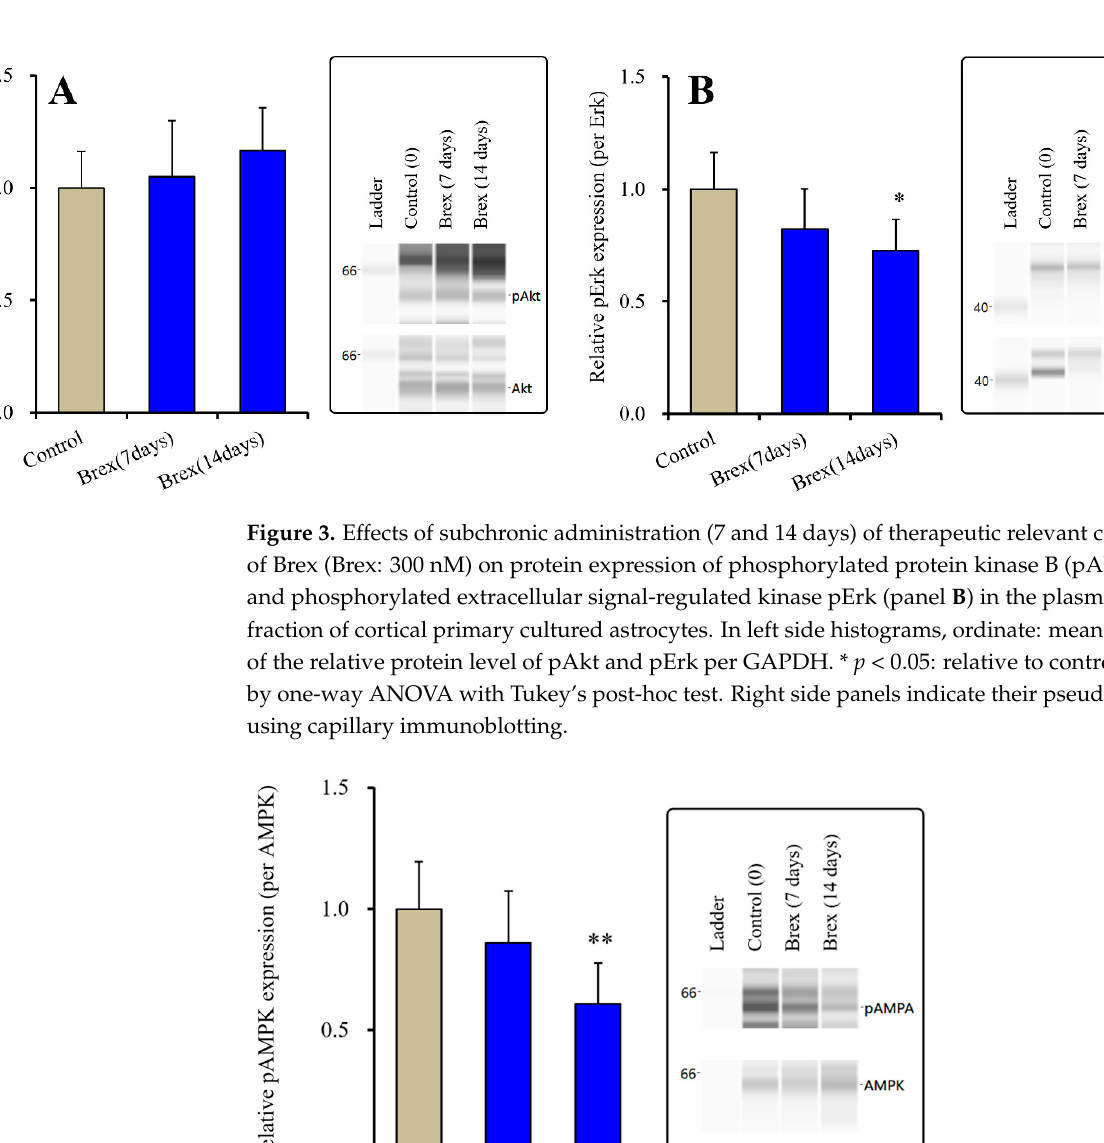
Figure 4. Effects of subchronic administration (7 and 14 days) of therapeutic relevant concentration of Brex (Brex: 300 nM) on protein expression of phosphorylated adenosine monophosphate-activated protein kinase (pAMPK) in the cytosol fraction of cortical primary cultured astrocytes. In left side histograms, ordinate: mean ± SD ( n = 6) of the relative protein level of pAMPK per GAPDH. ** p < 0.01: relative to control (Brex-free) by one-way ANOVA with Tukey’s post-hoc test. Right side panels indicate their pseudo-gel images using capillary immunoblotting.